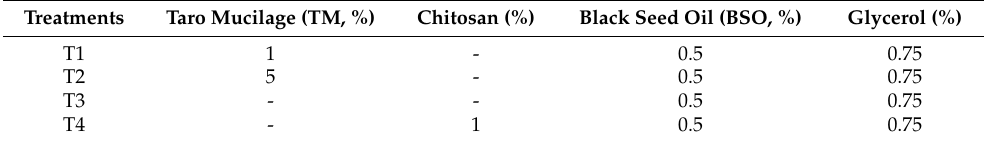
Table 2. Different coating